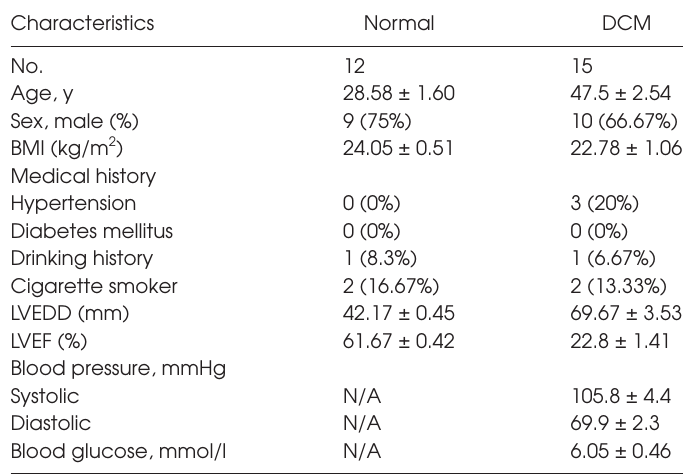
Table 1. Clinical information of donors with normal hearts and patients with dilated cardiomyopathy (DCM).